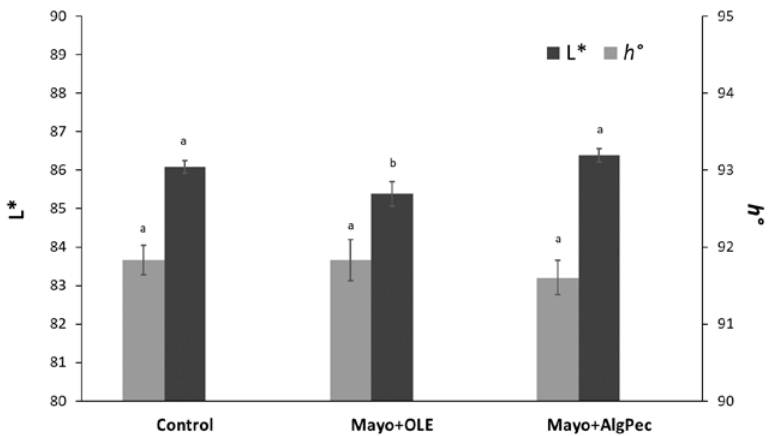
Figure 3. Color properties in terms of the lightness (L*) and hue angle ( h° ) of the mayonnaise samples under investigation. Different letters for parameters are significantly different by Tukey’s HSD test ( p < 0.05).